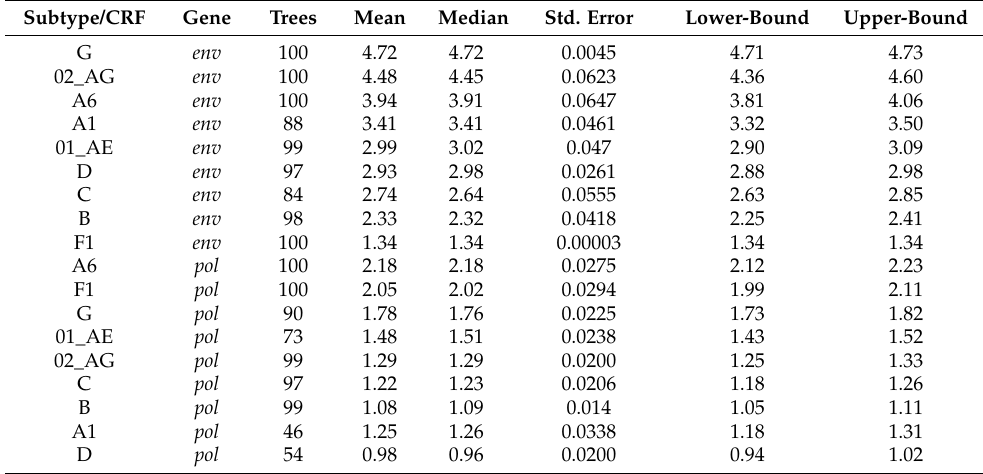
Table 2. Substitution rates in pol and env . The table below reports the calculated pol and env substitution rates ( × 10 − 3 ssy ) for all analyzed subtypes and CRFs. The mean, median, standard error, and the lower and upper bounds of the 95% CIs are reported. The table is sorted by the median rate, in a descending manner. The table excludes trees that indicated either a negative RTT slope or r < 0.3 (see text). See Table S1 for complete